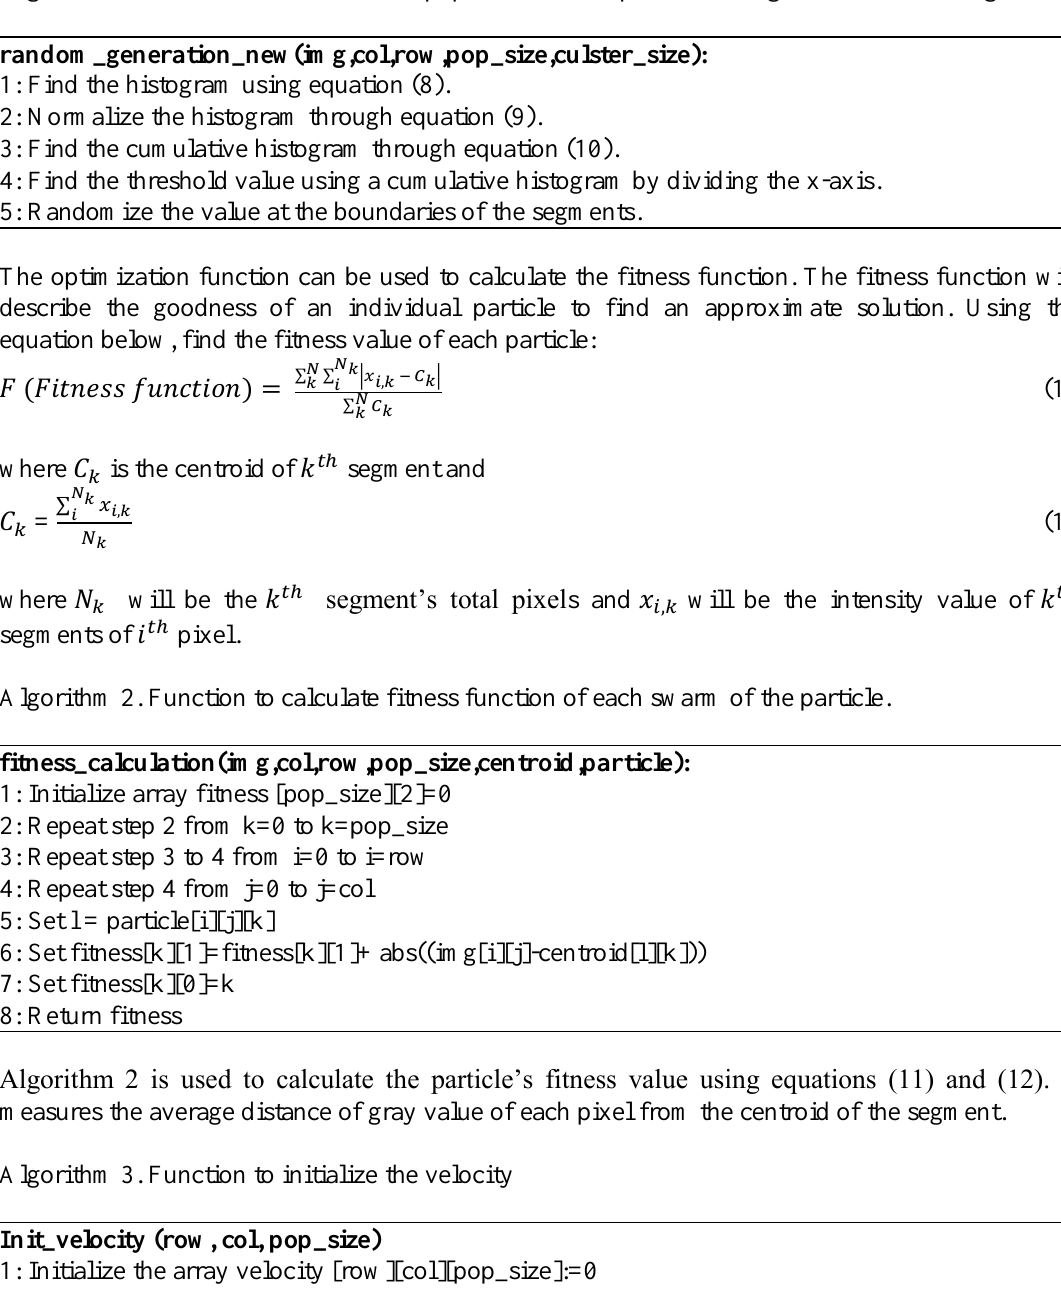
Algorithm 1. Function to initialize the population of the particle through cumulative histogram.